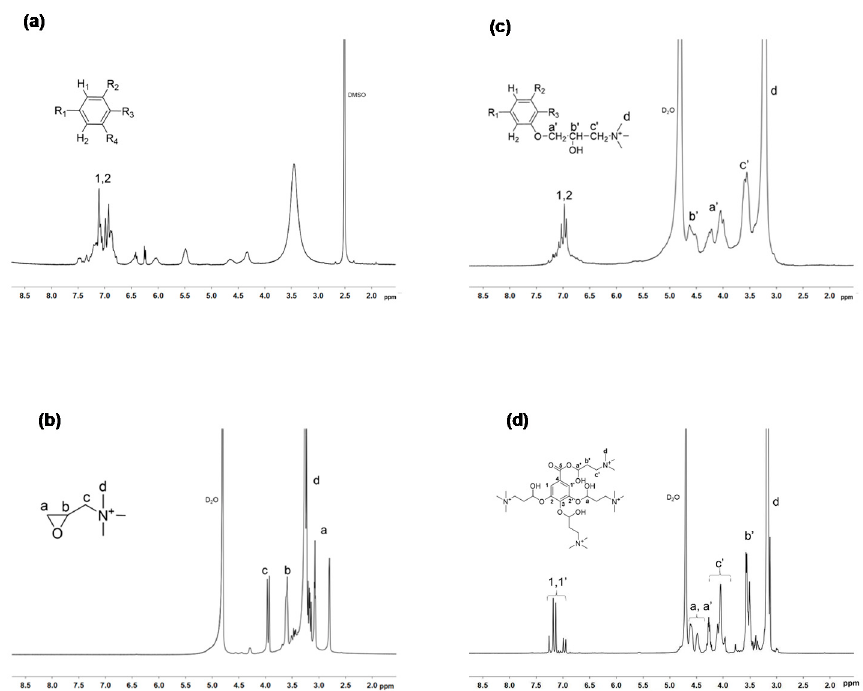
Figure 4. 1 H NMR spectra of ( a ) tannic acid in DMSO, ( b ) GTMA in D 2 O, ( c ) TA- N(CH 3 ) 3+ in D 2 O, and ( d ) GA-N(CH 3 ) 3+ in D 2 O.